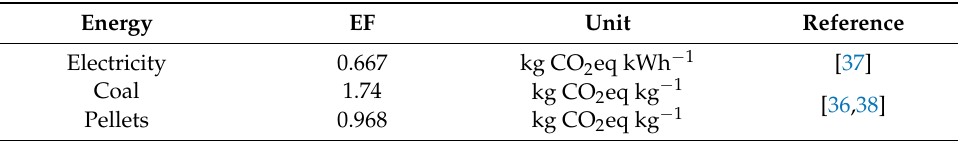
Table 3. Emission factors of different energy sources.